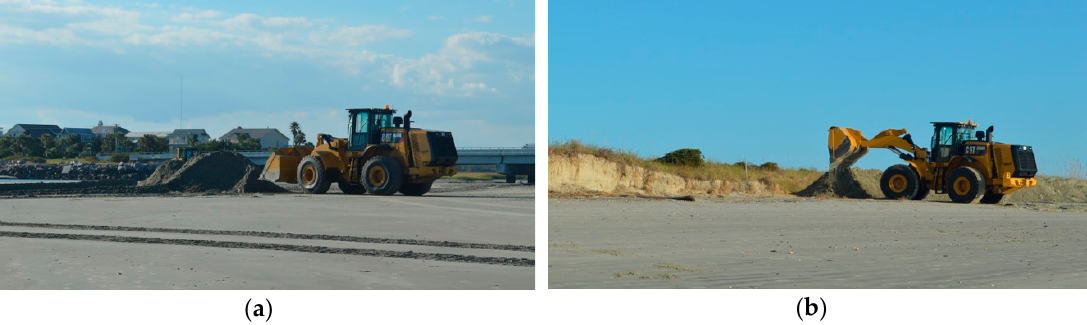
Figure 1. Sand scraping along the Isle of Palms, SC where ( a ) shows the sand source in nearshore and ( b ) shows the emplacement of the sand along the former primary dune line.